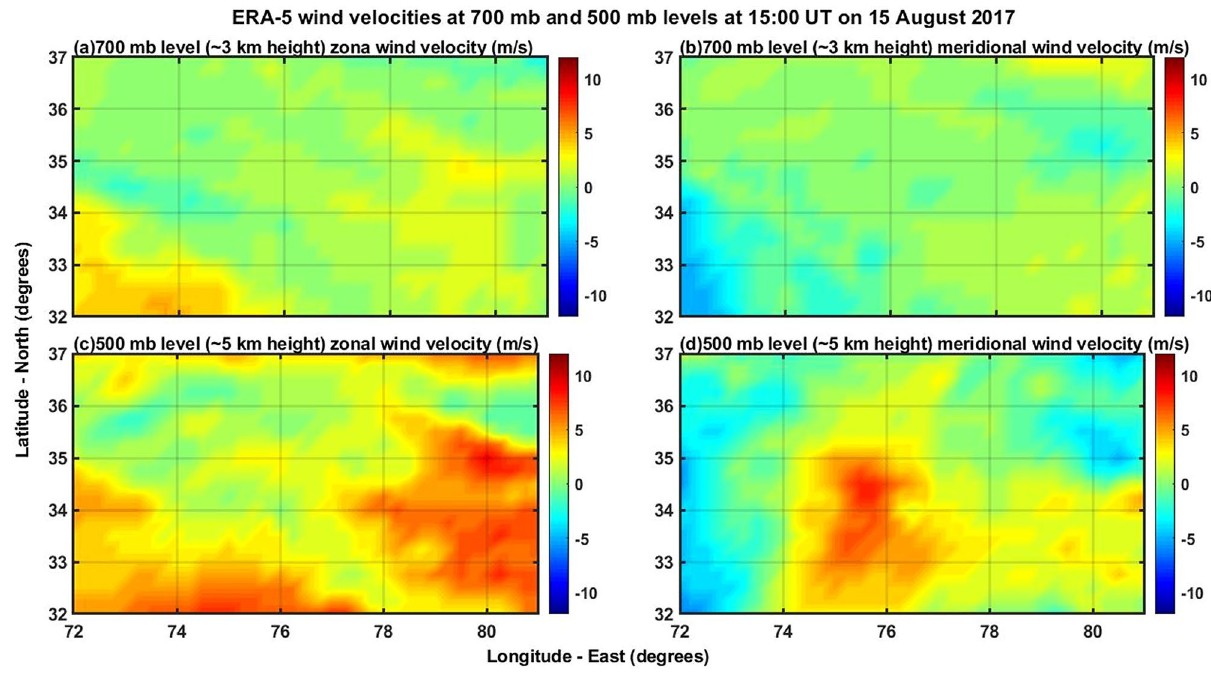
Figure 12. Depicts the ECMWF reanalyses 5 (ERA-5) zonal and meridional wind velocities at 700 mb and 500 mb levels at 15:00 UT on 15 August 2017.